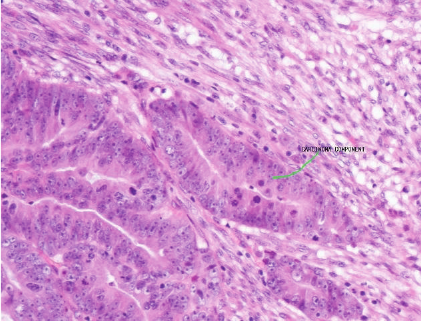
Figure 4: Immunohistochemistry showing positive staining for CK20 in the carcinomatous component.